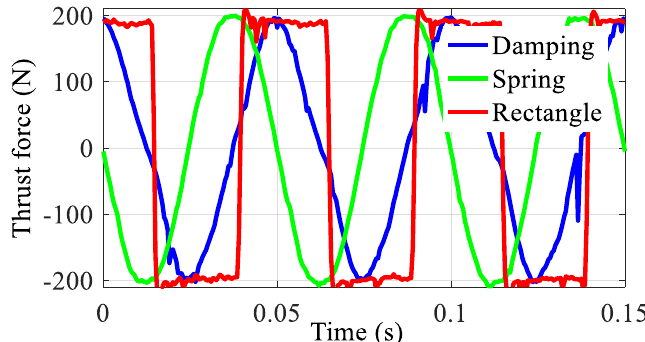
Figure 11. Different modes of force load. Figure 11. Di ff erent modes of force